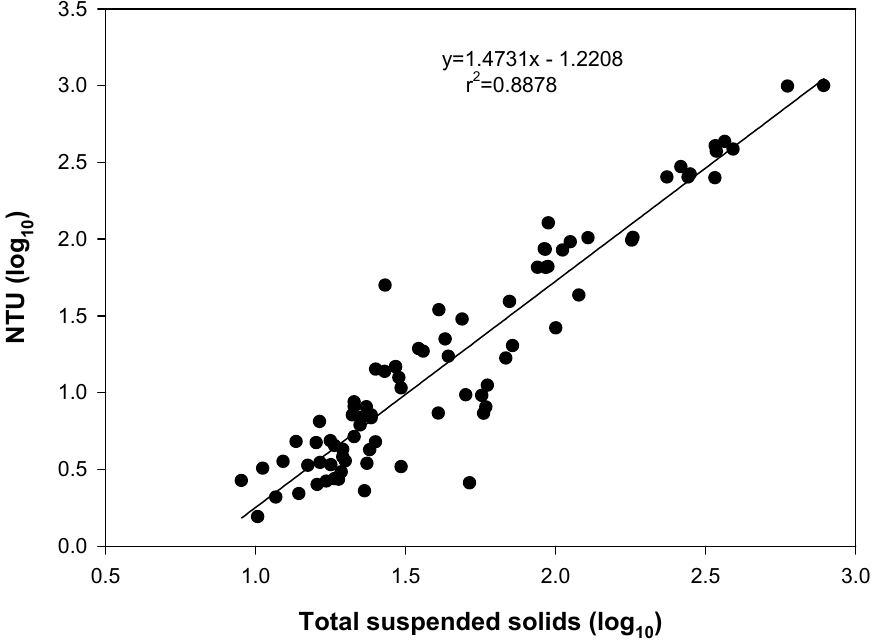
Figure 3. Correlation between total suspended solids (TSS) and nephelometric turbidity units (NTU) measured in shipboard tests.